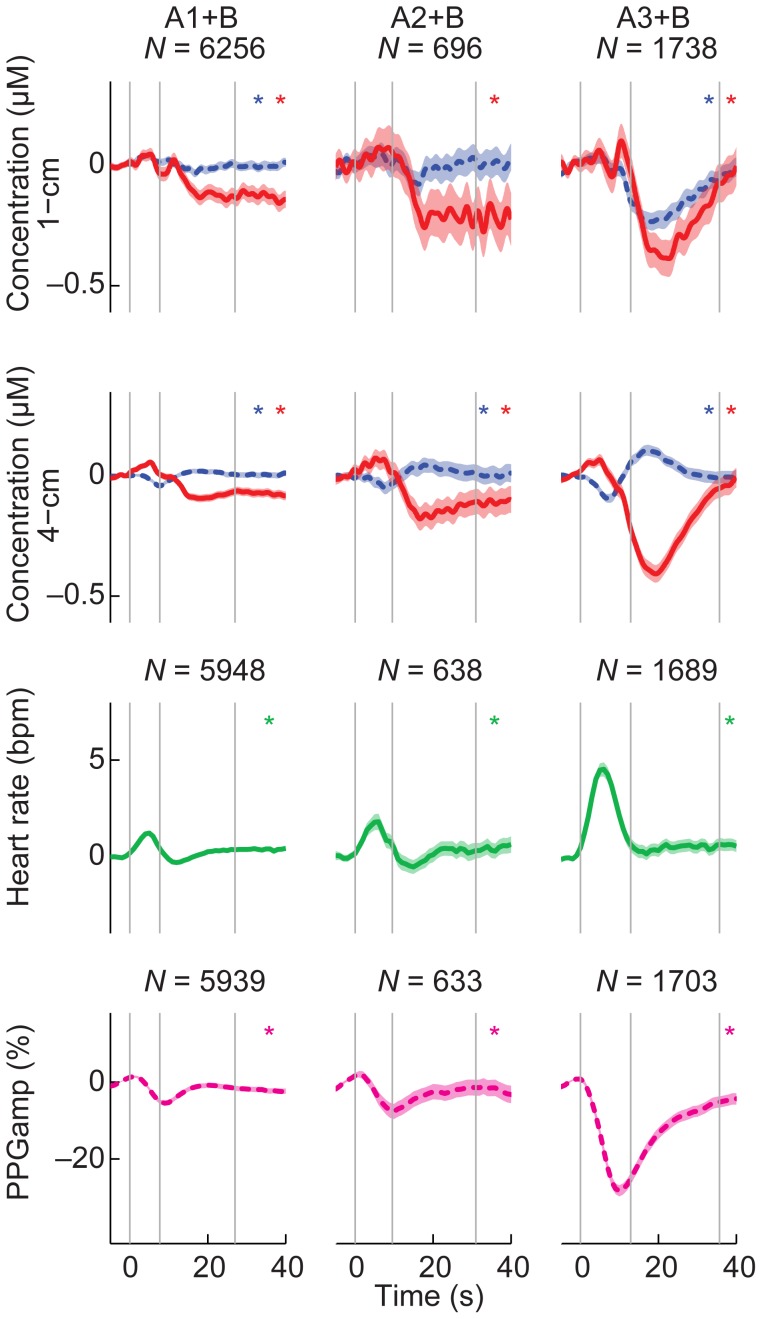
Averaged NIRS signals and cardiovascular signals in CAP subtypes.Rows represent individual NIRS channels and cardiovascular signals and columns separate CAP subtypes. Red solid line is Δ[HbO2] and blue dotted Δ[HbR] multiplied by two to show changes in the same scale. The shading depicts the 95% confidence interval of the mean and asterisks mark signals with significant changes during the cycle (one-way ANOVA with FDR-adjusted p-values). The vertical gray lines indicate the start of phase A, the average start of B and the average end of B. N indicates the number of cycles that have been averaged together and is same for both NIRS channels and signals. The cycle A3+B produces the strongest cortical and systemic hemodynamic changes. Changes in Δ[HbR] differ between the 1-cm and 4-cm channels.